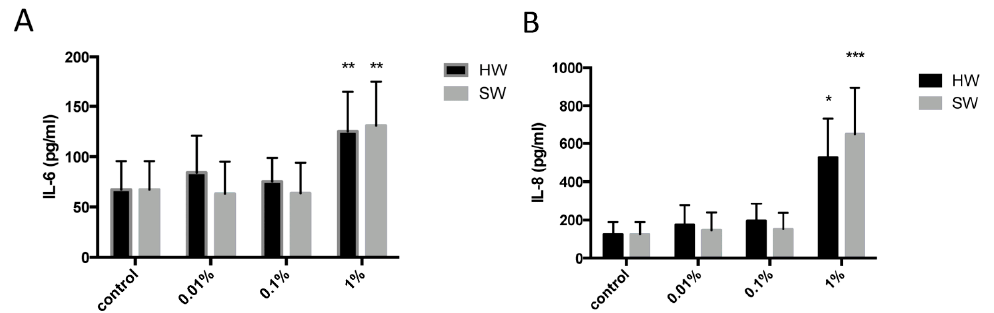
Figure 3. IL-6 ( A ) and IL-8 ( B ) induction from Hardwood and Softwood smoke exposure at lower concentrations. Human primary lung fibroblasts ( n = 6) were stimulated with hardwood and softwood smoke extract (0.01%, 0.1% and 1%) in 0.1% FBS/DMEM for 24 h. Cell free supernatants were collected and IL-6 ( A ) and IL-8 ( B ) release was measured via ELISA. Data were expressed in pg/mL and bars represent mean ± SEM. Comparisons between IL-6/IL-8 release from control and different concentrations of hardwood and softwood smoke extract made by one-way ANOVA with Tukey’s post-test. Significance is represented as * p < 0.05, ** p < 0.01 vs. control, *** p < 0.001 vs. control.